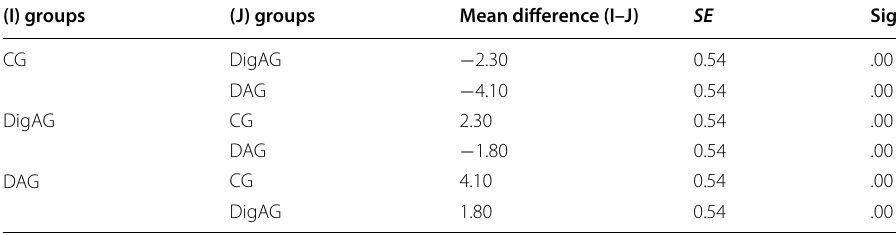
Table 10 Comparing speaking accuracy posttest of all groups by using a Scheffe test (I) groups (J) groups